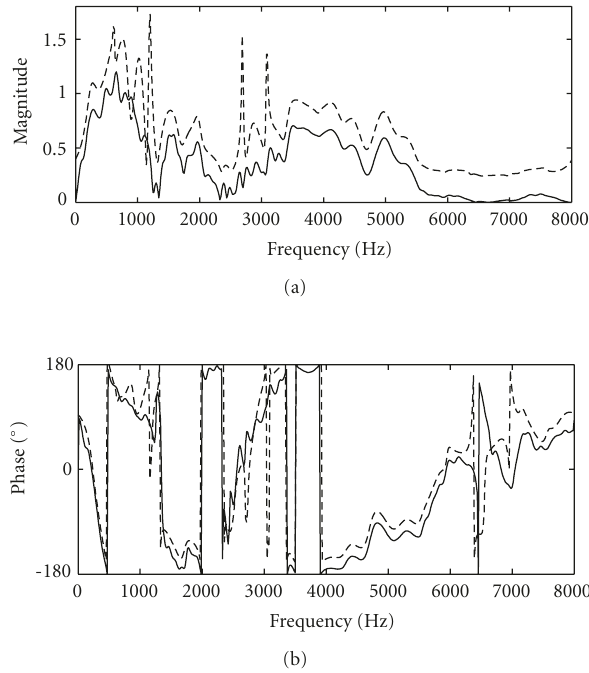
Figure 9: Case (C-2): (a) magnitude and (b) phase of ATF from demigration (solid line) and its model with N = 31 (dashed line). Magnitude and phase of model have an o ff set for better compara-